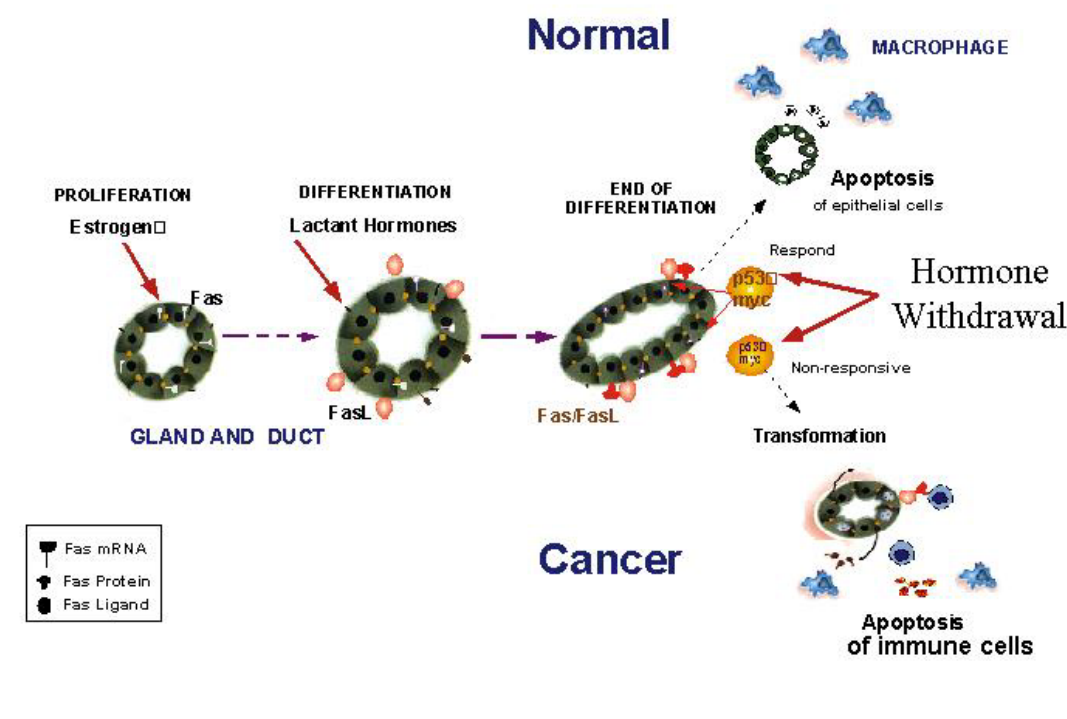
FIGURE 5 . Model of tissue remodeling, normal and